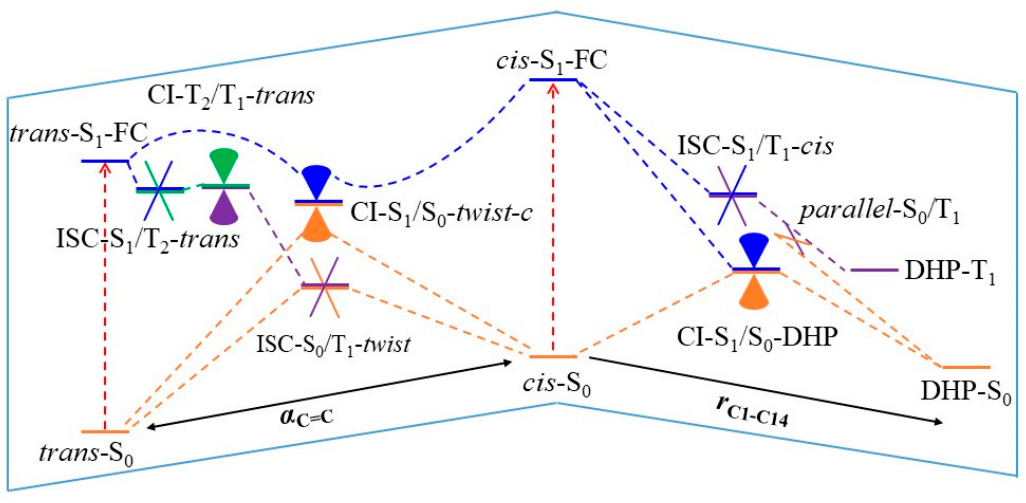
Figure 3. Photorelaxation pathways for DANS upon S 1 excitation.